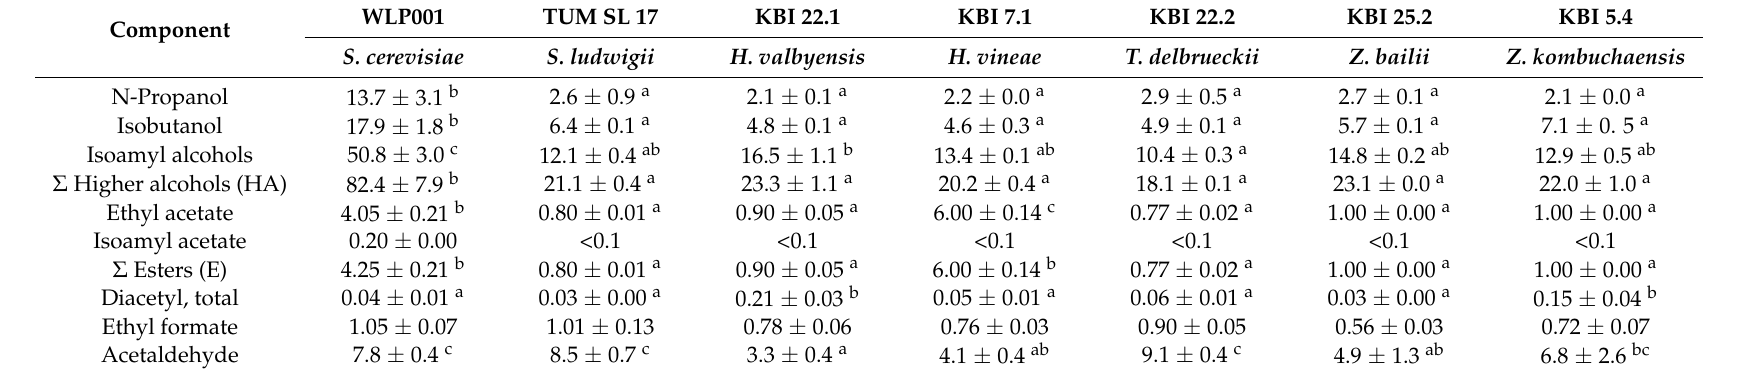
Table 6. Analysis of fermentation by-products of final beers fermented with investigated yeasts; values in mg/L.